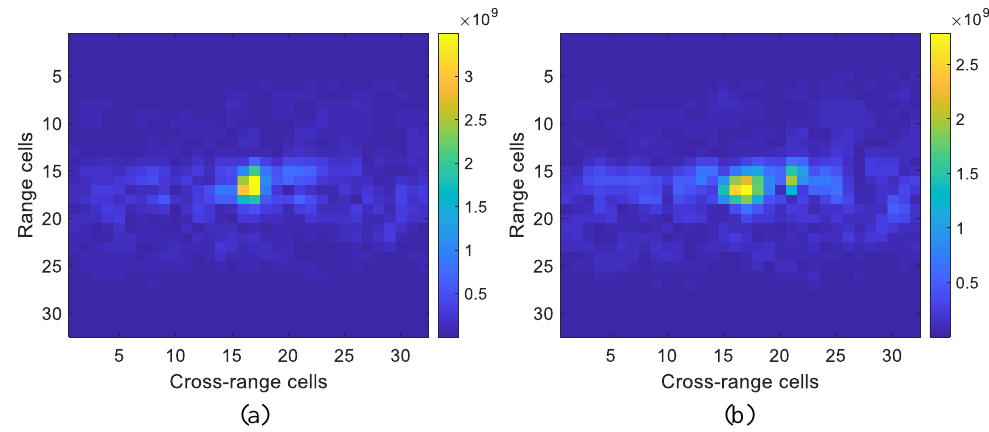
Figure 21. The imaging result of T4. ( a ) HPC-GMTIm (entropy = 3.46). ( b ) GHHAF method (entropy =